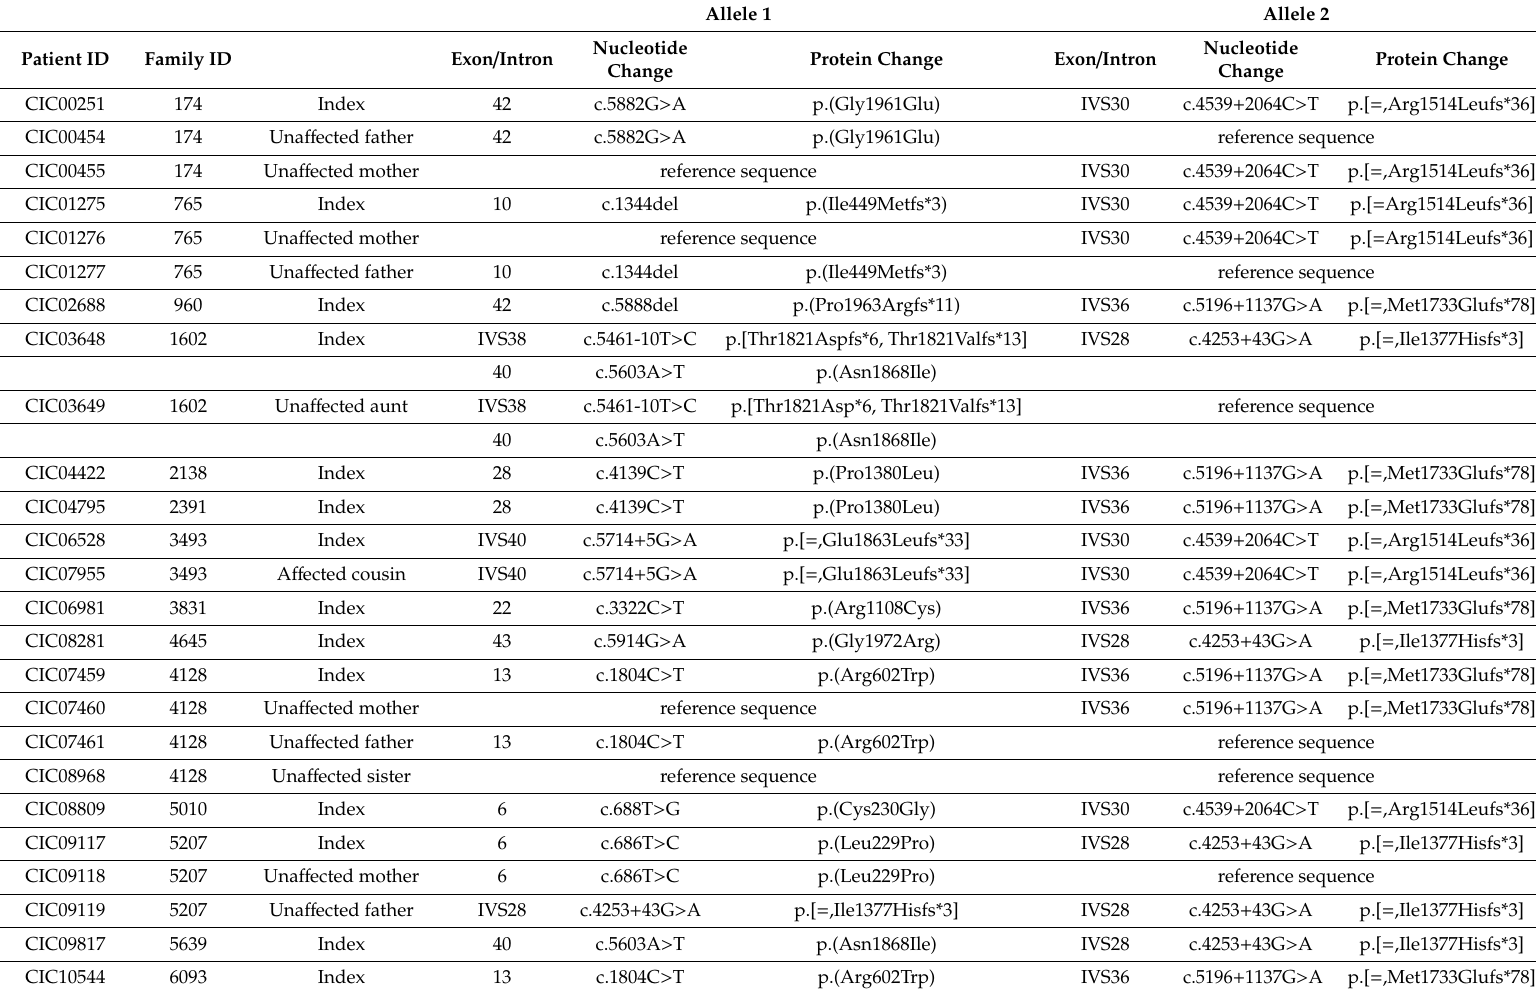
Table 1. Complete genotype and segregation analysis (when available) of patients carrying a deep-intronic variant on ABCA4 . Nucleotide positions and translation correspond to CCDS747.1 and NP_000341.2,